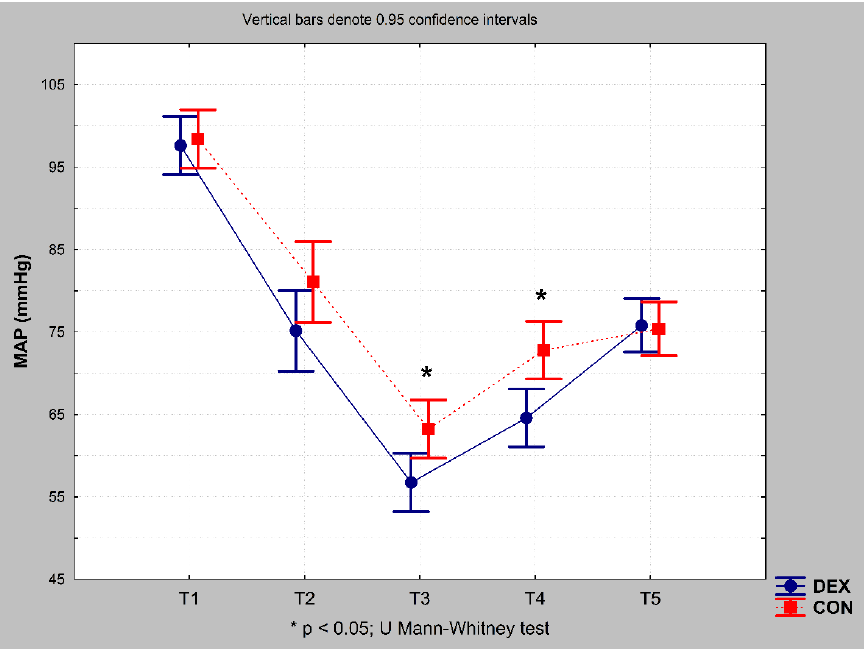
Figure 4. Mean arterial pressure in the DEX and CON groups during the procedure. MAP, mean arterial pressure; T1, initial; T2, 10 min after intubation; T3, 10 min after ECC institution; T4, 10 min after ECC weaning; T5, at the end of the procedure.